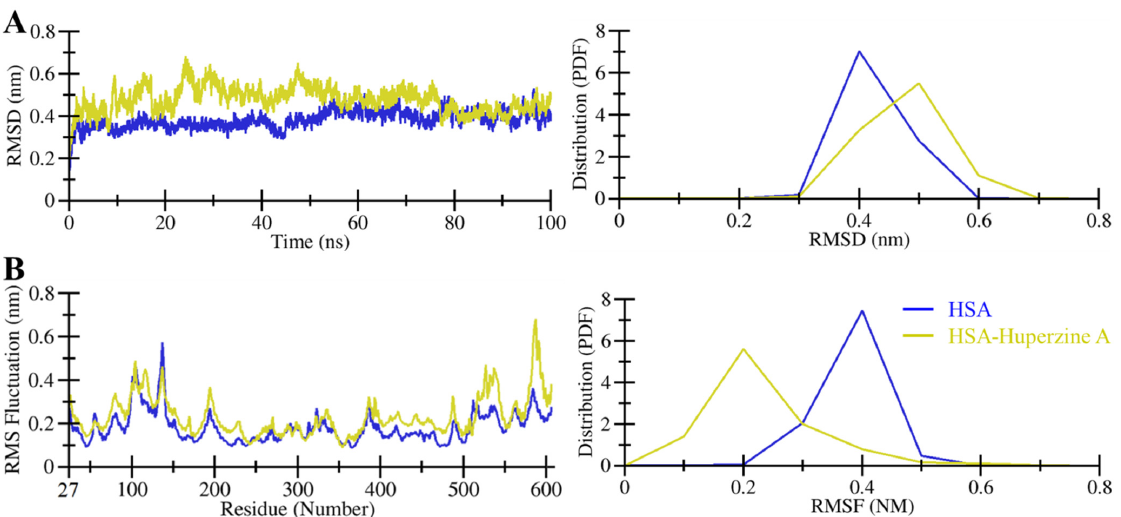
Figure 3. Dynamics performance of HSA. ( A ) RMSD plot of HSA and its docked complex with HpzA. ( B ) Residual fluctuation plot of HSA and its docked complex with HpzA.